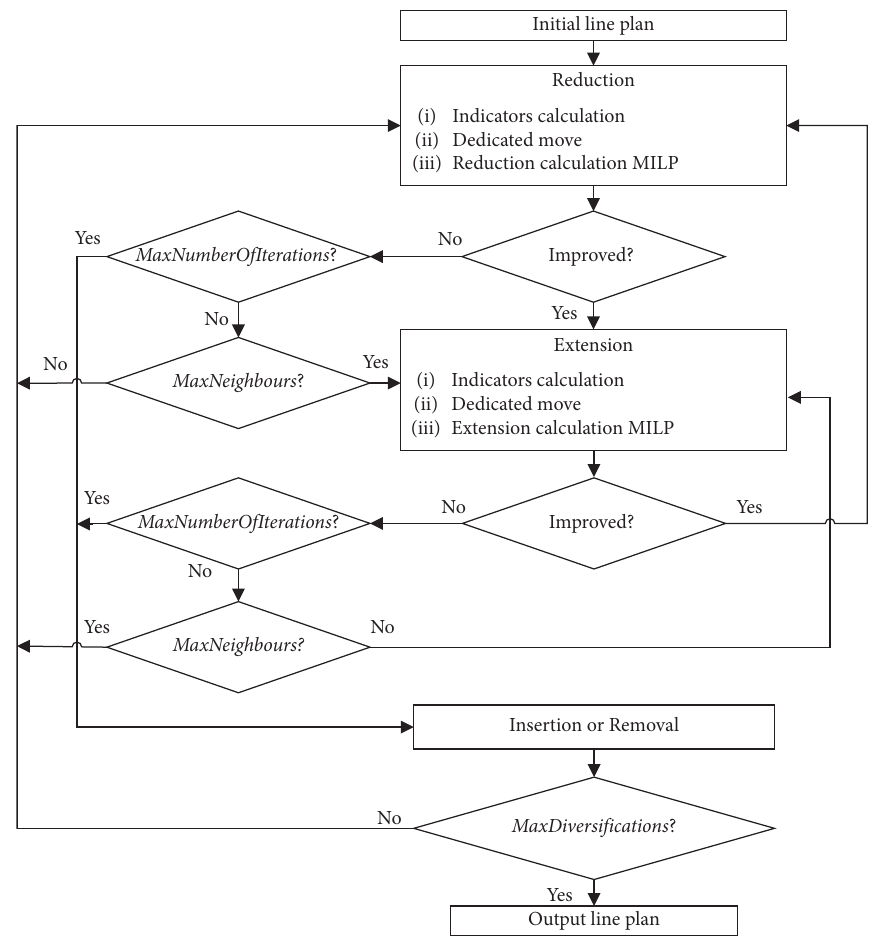
Figure 2: The process of MHIA for line planning optimization. Table 2: The shortest paths for passenger OD pairs on the small example